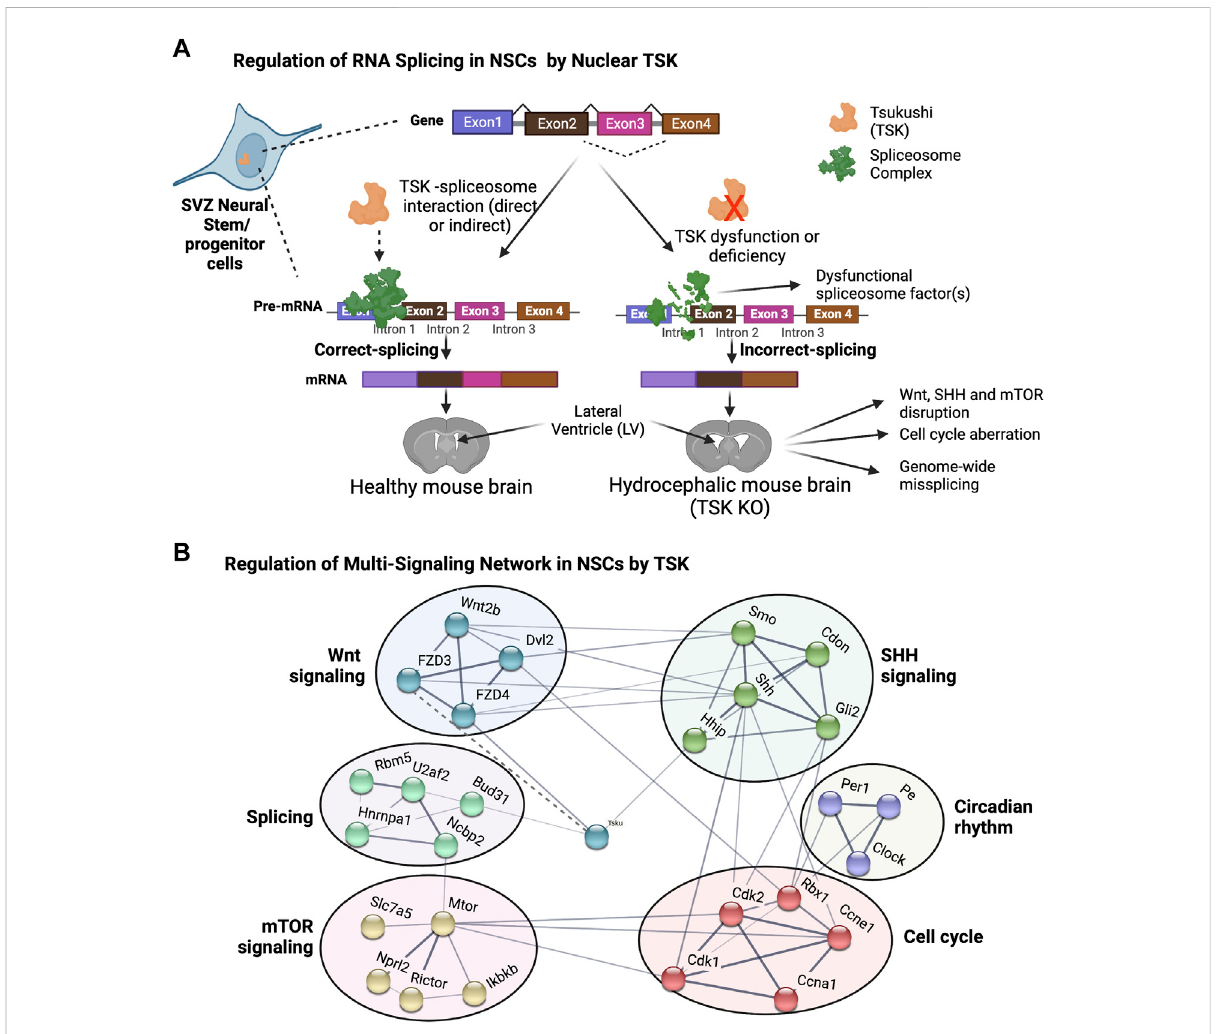
FIGURE 10 Proposed model for TSK in splicing and singling regulation in hydrocephalus. (A) Functional TSK expressed by stem/progenitor cells interacts with the spliceosome and ensures that pre-mRNA splicing is properly regulated, maintaining proper signaling and cell fate. Tsukushi de fi ciency or dysfunction,ontheotherhand,resultsinspliceosomalgenedysregulation,leadingtotheimproperspliceosomalcomplexformationandmissplicing ofpre-mRNA.Accordingly,thelossofcorrectsplicingaffectstheproteinfunctionandimpairsthesignalingprocess,causingLVenlargementby altering the NSCs. (B) String-based analysis of protein-protein interactions of TSK with development associated multi-signaling components. The nodesrepresentproteins.Colorsofthenodesrepresenttheclustergroups(K-meanclustering).Thethicknessoftheedges(solidline)isproportional to their con fi dence scores (Minimum con fi dence score for the interaction = 0.4). The dotted line indicates that the interaction is not yet included in the string database and evident in our previous publication (Ito et al.,